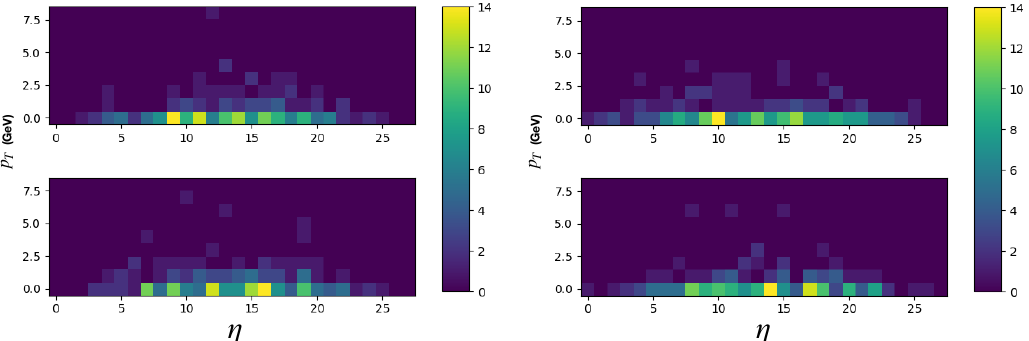
Figure 7: Illustrative 2D histograms for SUSY1 (left) and ALP case (right) averaging over 200